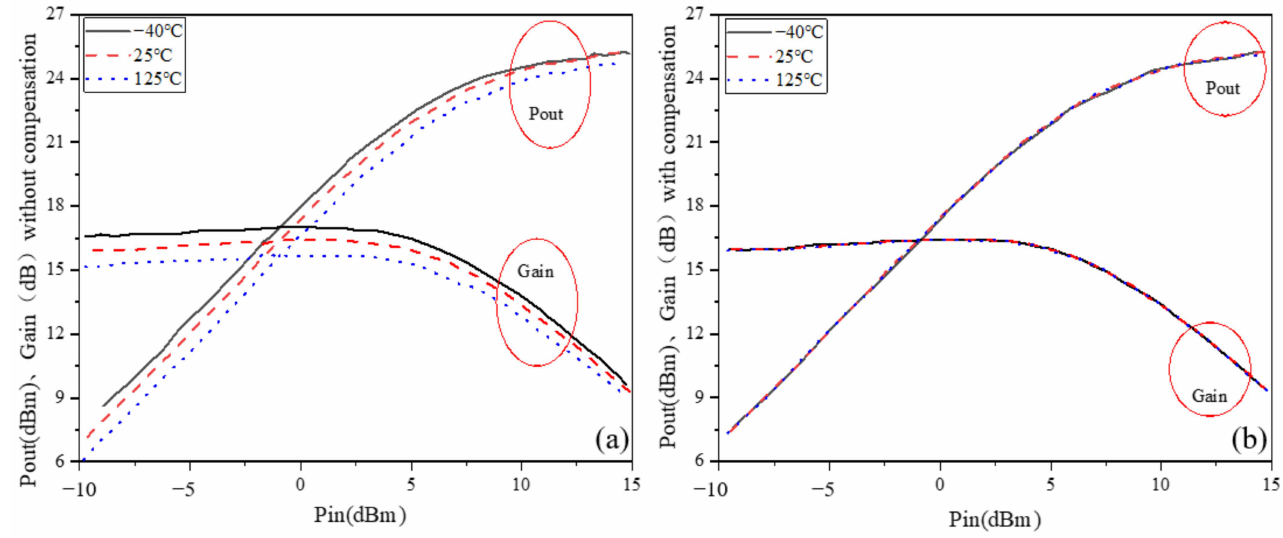
Figure 8. Output power versus temperature variation: ( a ) without temperature compensation; ( b ) with temperature